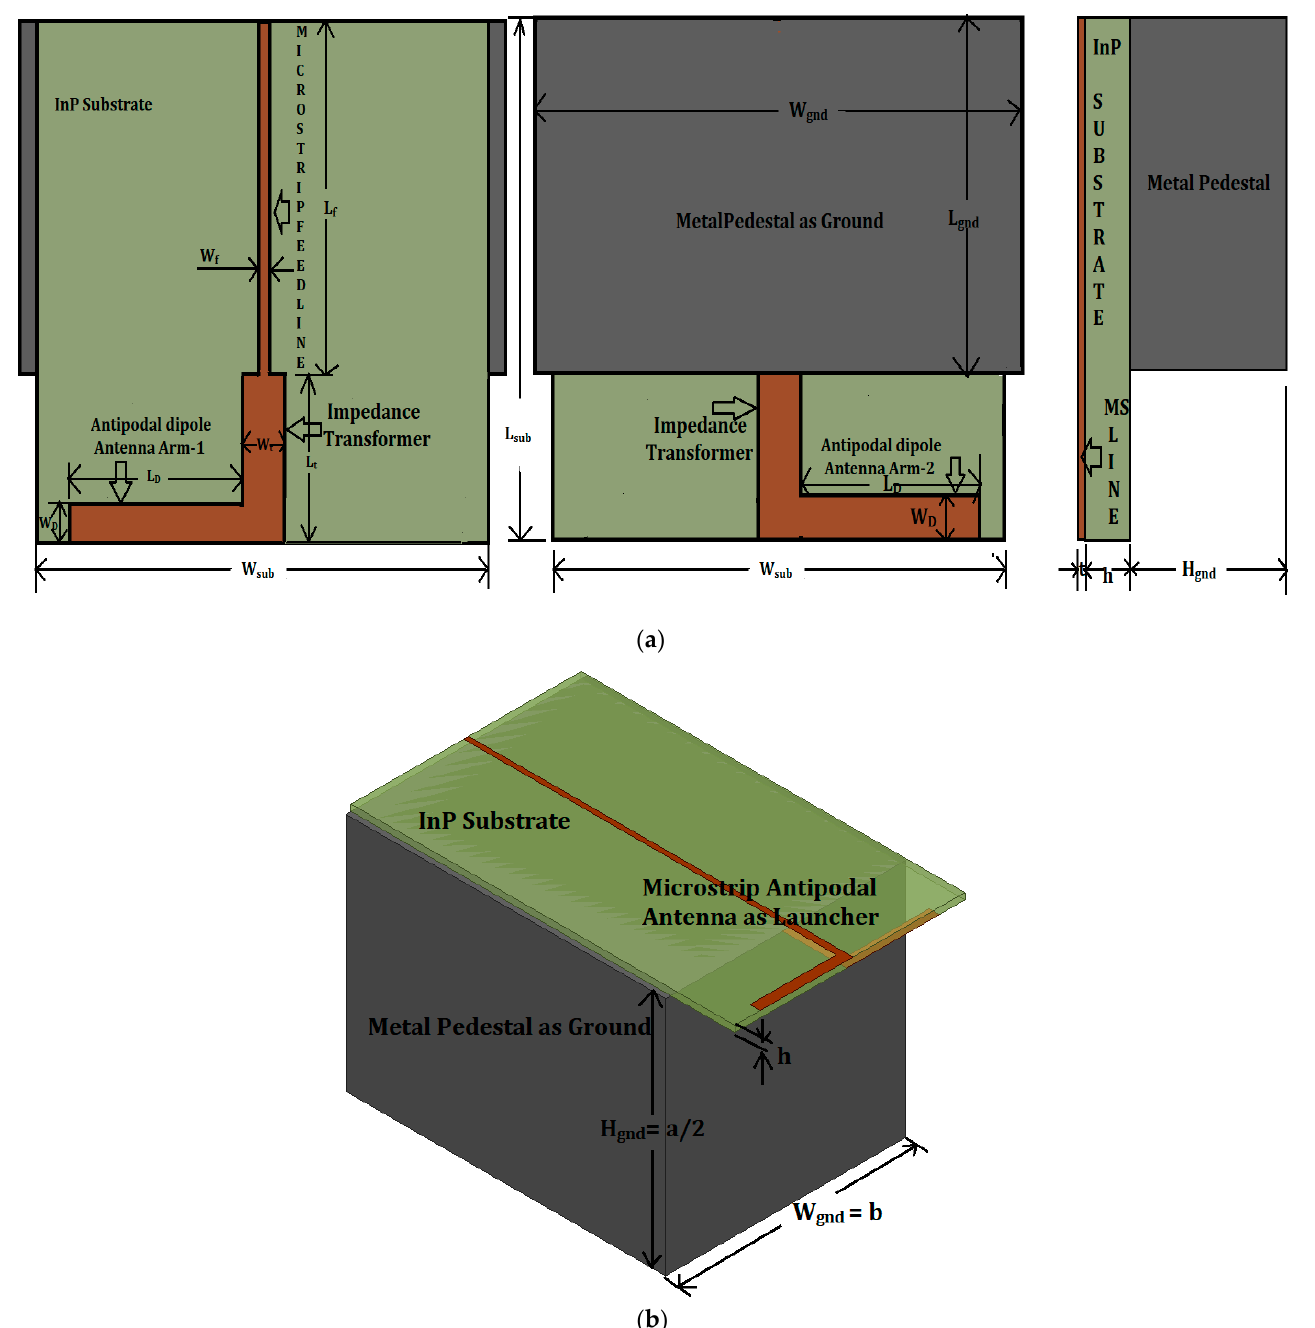
Figure 1. V-band inline transition of the MSL-to-RWG transition.